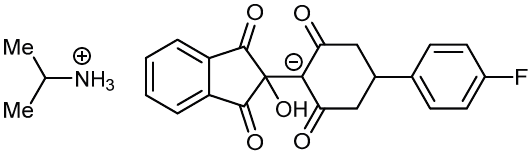
Figure 3. Structure of the ammonium salt 4d’ .